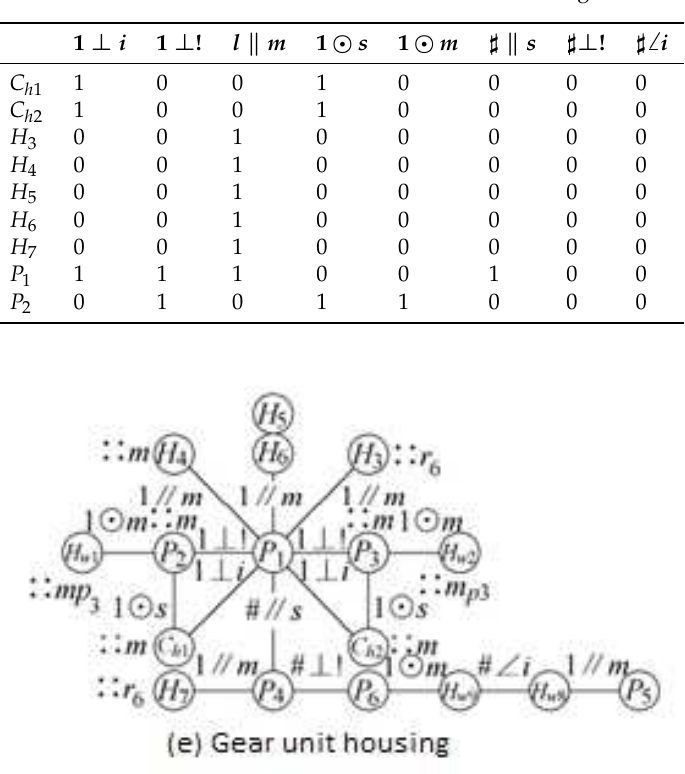
Table 2. The formal context of 3D structure model in Figure 6.